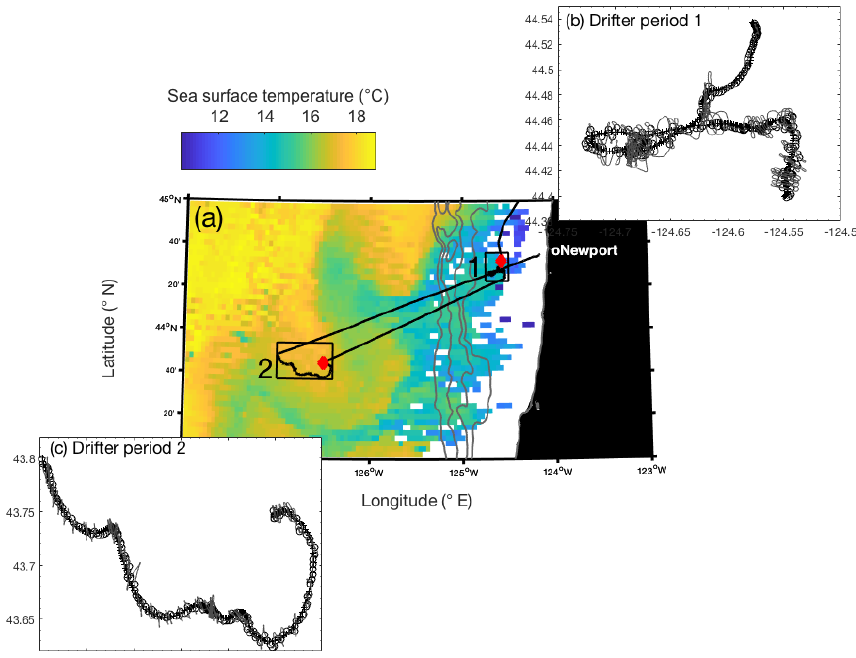
Figure 1. (a) Map of Aqua MODIS-derived 8d composite sea surface temperature (11µm, nighttime) from 21 to 28 August 2017, overlapping with the duration of both drifter deployments. The two hollow boxes on the map denote the location of drifter tracks, with the red diamonds indicating the location of the initial release. Gray bathymetry contours represent 0, 500, 1000, 1500, and 2000m depths. Panels (b) and (c) show a detailed view of the two drifter tracks (cross symbol), with the ship’s track shown in a light gray line and open circles denoting times when the ship was < 1 . 5km away from the drifter position. Only measurements taken at these crossover locations were used for